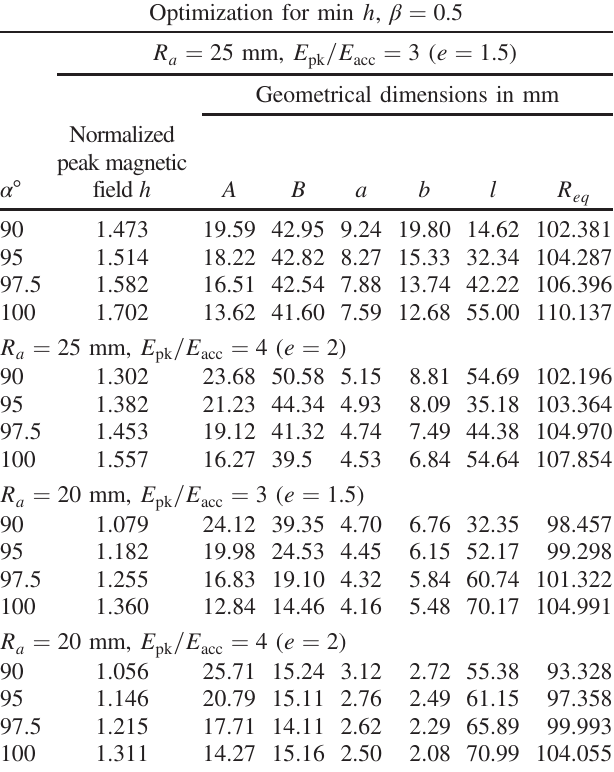
24. Normalized magnetic peak field for different angles of the wall slope for β ¼ 0 . 4 TABLE VIII. Values of h ¼ H optimized inner cell (two elliptic arcs and a straight segment) vs the slope angle α . Optimization for min H ≥ 3 mm. =E = 42 , and dimensions of r pk acc c =E (or min h ). pk acc